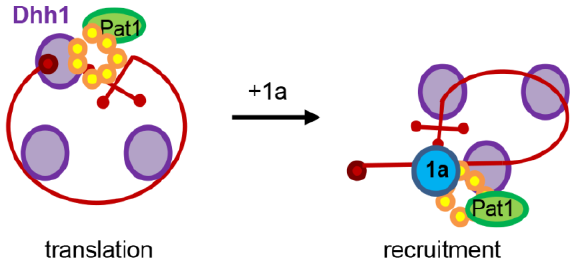
Figure 3. Model of the Lsm1–7/Pat1 complex and Dhh1 function in viral RNA translation and recruitment.